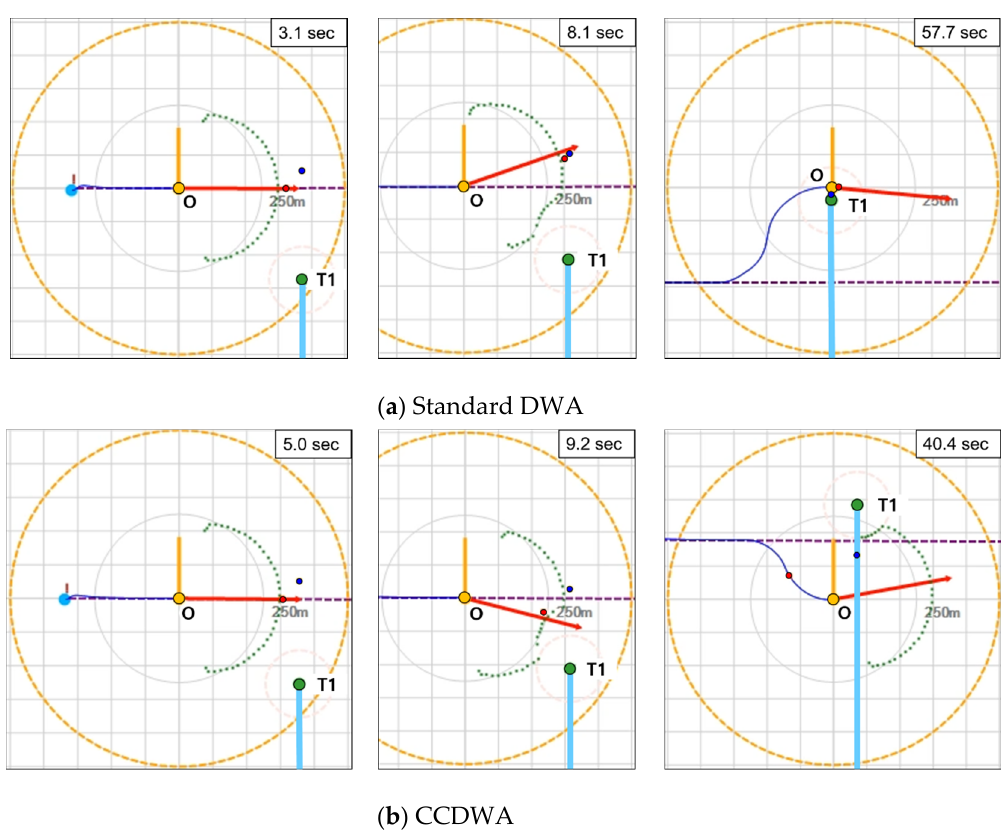
Figure 8. Simulation in crossing situation with dynamic obstacles: an orange dot is our own ship, a green dot is the obstacle ship, a blue line is our own ship’s trajectory, and a light blue is the obstacle’s trajectory.